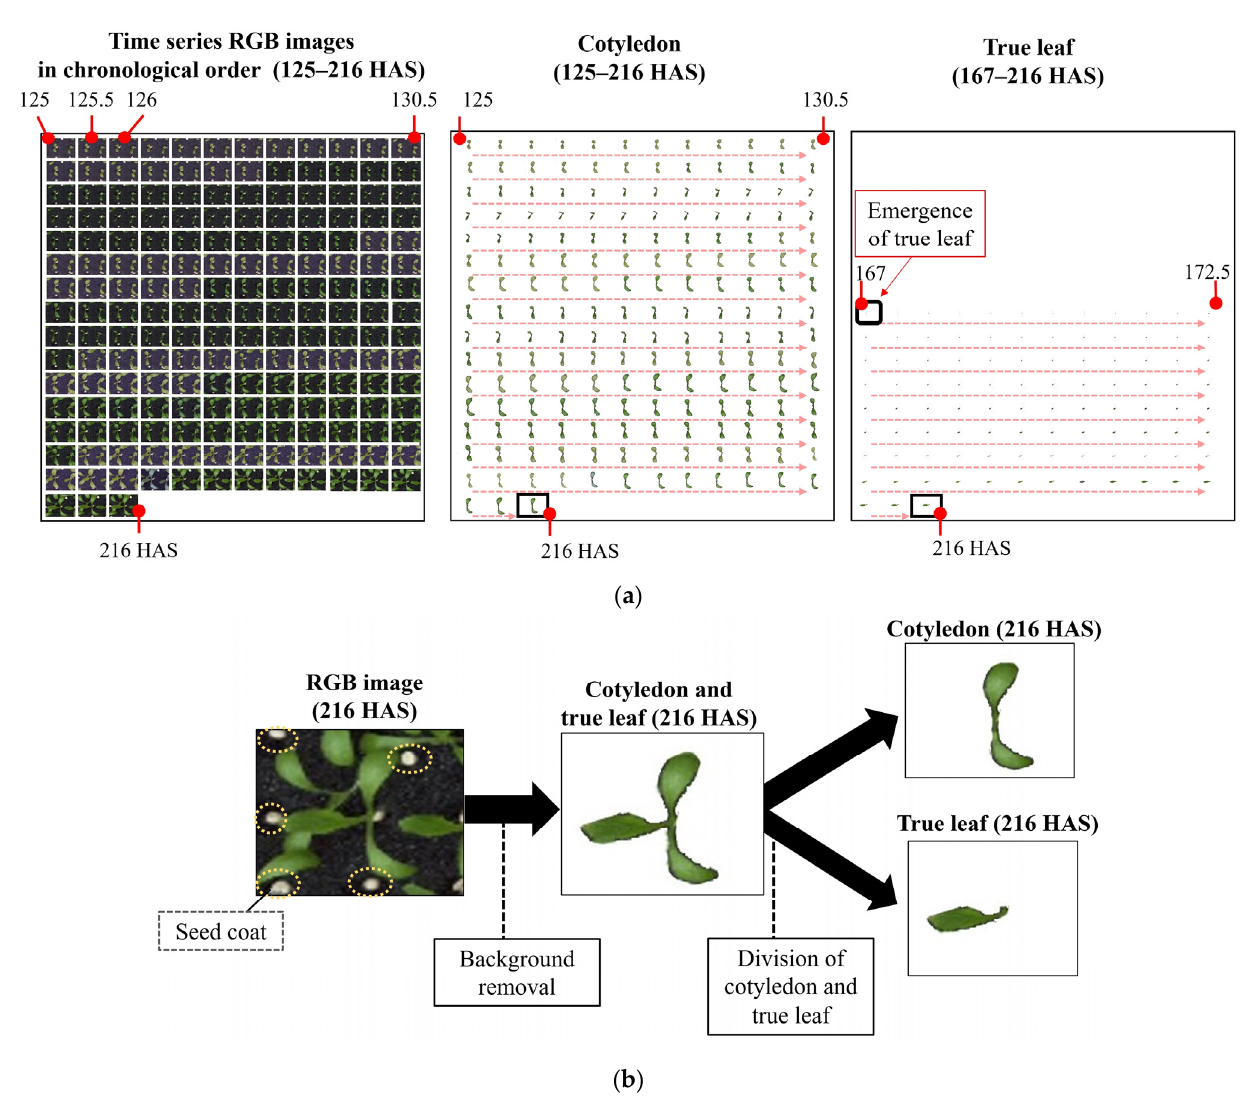
Figure 2. The time series RGB images of the same seedling, in chronological order, at 0.5 h intervals from 125 to 216 hours after sowing (HAS). This seedling, with nutrients and at high PPFD levels (Nutrients-H) (202 μ mol m − 2 s − 1 ), reached the largest projected area of cotyledon and true leaves among others 216 HAS. ( a ) Time series RGB images, time series images of cotyledon, and time series images of true leaf after its emergence. The cotyledon unfolding time was 66.5 h. ( b ) Magnified images of the same seedling at ( a ) 216 HAS: RGB image, cotyledon, and true leaf after background removal, and separated images of cotyledon and true leaf.